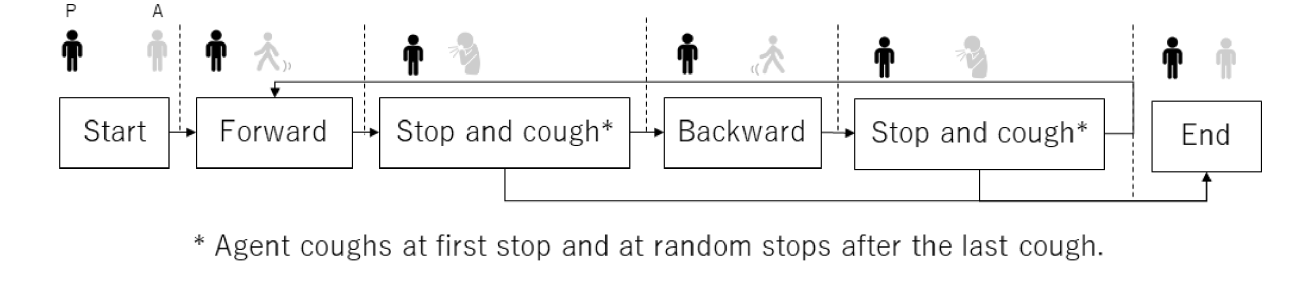
Fig 2. Summary of agents’ actions. Participants can control forward/backward behaviors until choosing a distance.